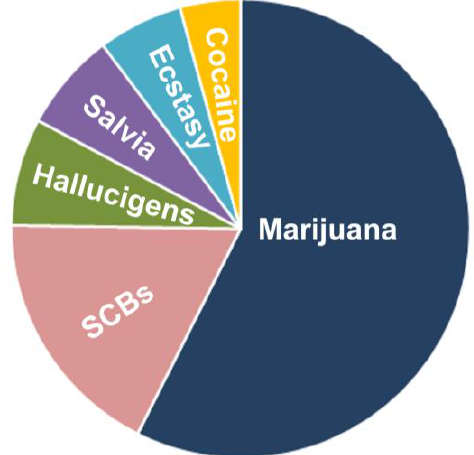
Figure 1. Pie illustration outlining the synthetic cannabinoid (SCB) abuse rate among high school-going children. SCB abuse is the most widespread among young people; of the illicit drugs most used by high school seniors, the use of SCBs are second only to that of marijuana (http://www.drugabuse.gov/publications/drugfacts/spice-synthetic-marijuana). The most common reasons for using SCBs were affordability, inability to detect SCBs in standard drug tests, and perceived physical and emotional benefits.